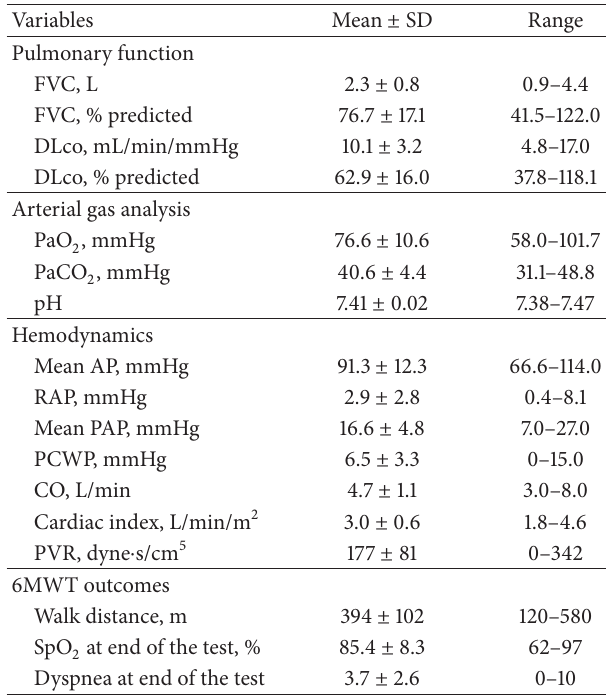
Table 1: Patient characteristics. Table 2: Pulmonary function, arterial gas analysis, hemodynamics, and 6min walk test